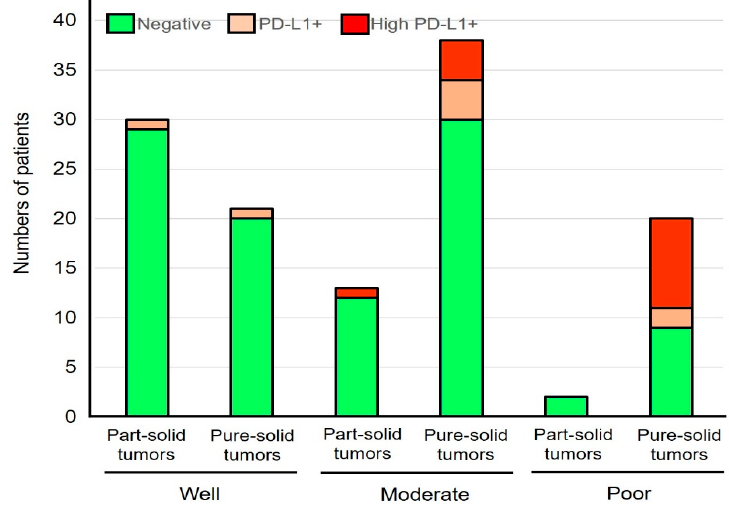
Figure 2. The correlation between PD-L1 positivity and tumor differentiation in part-solid LADs and pure-solid LADs. PD-L1 + indicates tumors with PD-L1 membrane staining in 1–49% of tumor cells and high PD-L1 + indicates those with PD-L1 membrane staining in ≥ 50% of tumor cells.